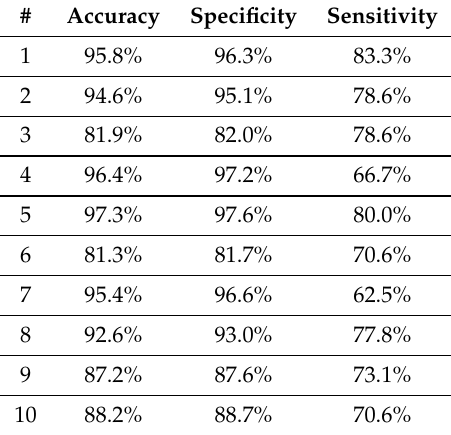
Table 3. Accuracy, specificity and sensitivity of our approach at detecting abnormal stride instances. Parameters used were ω = 0.15 and τ = −